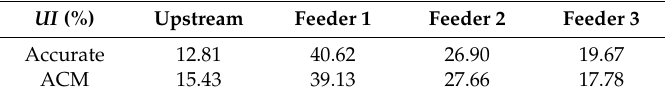
Table 10. Unbalance contribution estimation